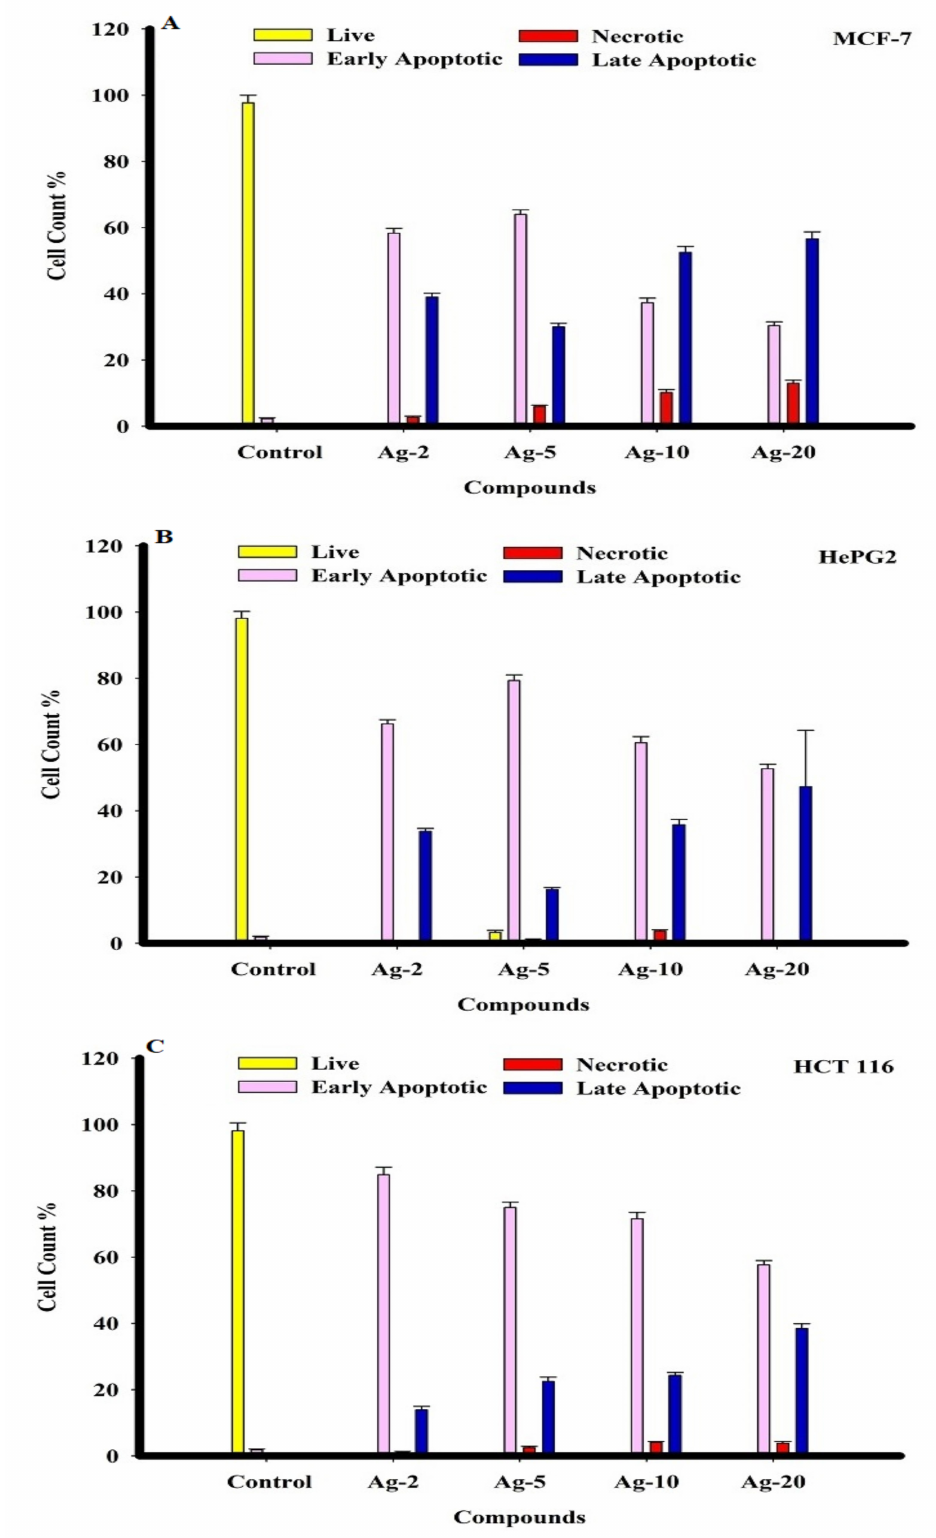
Figure 9. The percentage of apoptotic/necrotic cells of MCF-7, HePG2, and HCT 116 tumor cells was determined 48 h after treatment with silver